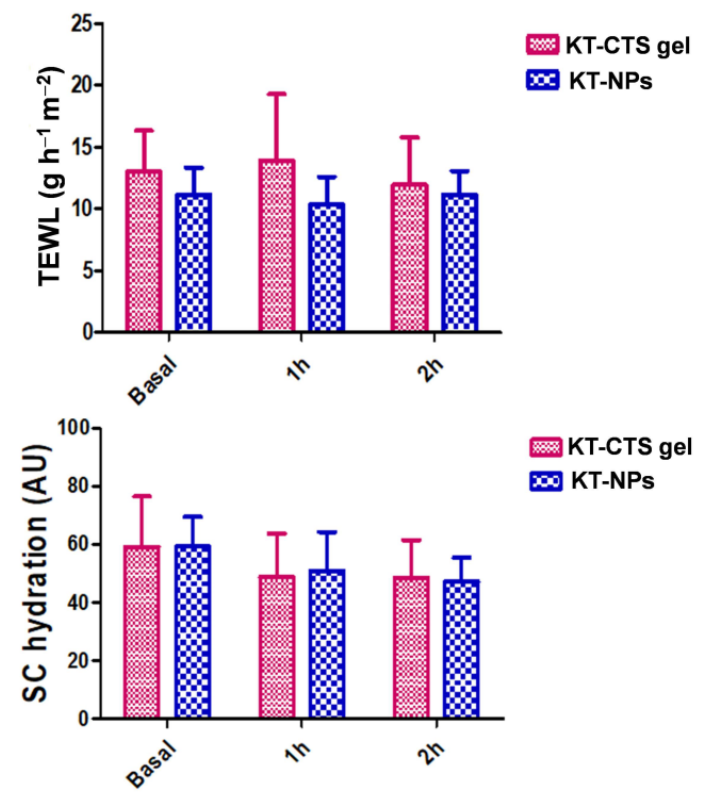
Figure 6. Biomechanical properties in human volunteers before the formulations applications (Basal) 1 h and 2 h post-application: TEWL for both formulations; and the evolution of the stratum corneum hydration for both formulations. The formulation of the NPs was the one that exhibited the highest reduction in inflammation, and both formulations showed greater anti-inflammatory efficacy than the reference KT solution in acetone. All differences were statistically